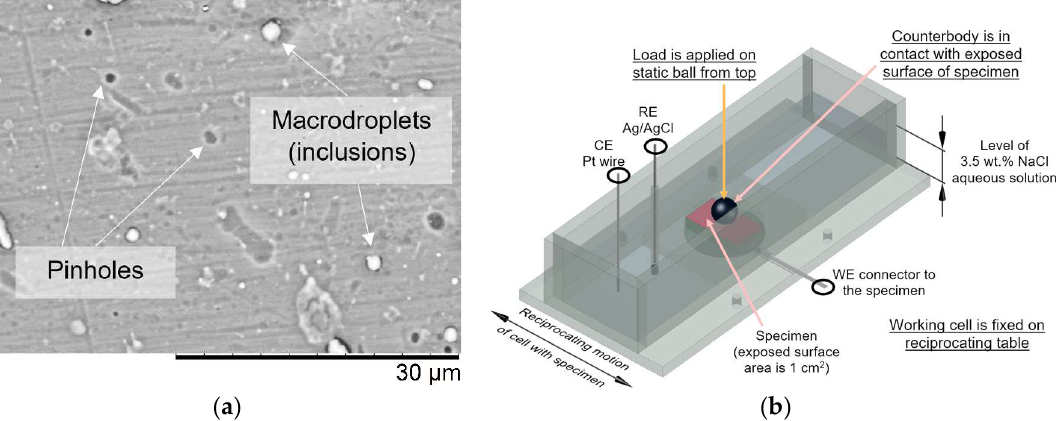
Figure 2. Surface defects on the as-deposited AlCrN coating on the stainless steel AISI 316L substrate were detected in a SEM micrograph ( a ); and a schematic illustration of reciprocating tribo-corrosion test setup ( b